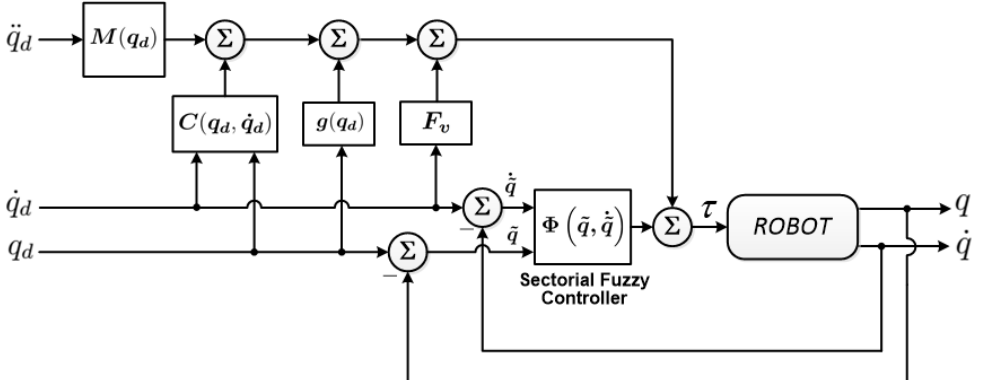
Figure 5. Proposed Sectorial Fuzzy Control plus feedforward. The feedforward block is formed by the dynamics of the robot evaluated at the desired trajectories, their first and second derivatives. The controller is of a special fuzzy class, named sectorial, due to its sectorial properties, and it performs the tasks of a PD controller, but as a Mamdani fuzzy system of its